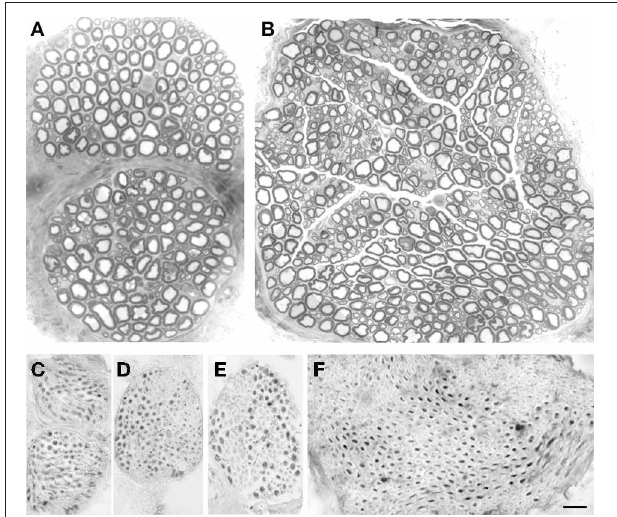
FIGURE 2 | Morphological and immunohistochemical studies of the branches of the brachial plexus to the pectoral nerves. Semithin sections showing fiber distribution in MATN (A) and LATN (B) . Large fibers are prevalent in MATN (A) compared with LATN (B) , in which fiber distribution is bimodal. ChAT immunohistochemical analysis showed that almost all fibers are positive in MATN (C and D) , compared to LATN (E) and quadriceps (F) . BAR: (A and B) : 15 µ m; (C–F) : 30 µ m. Adobe Photoshop v. 8 was used to size, and crop micrographs, and to construct plates. Images were enhanced only for contrast and brightness.